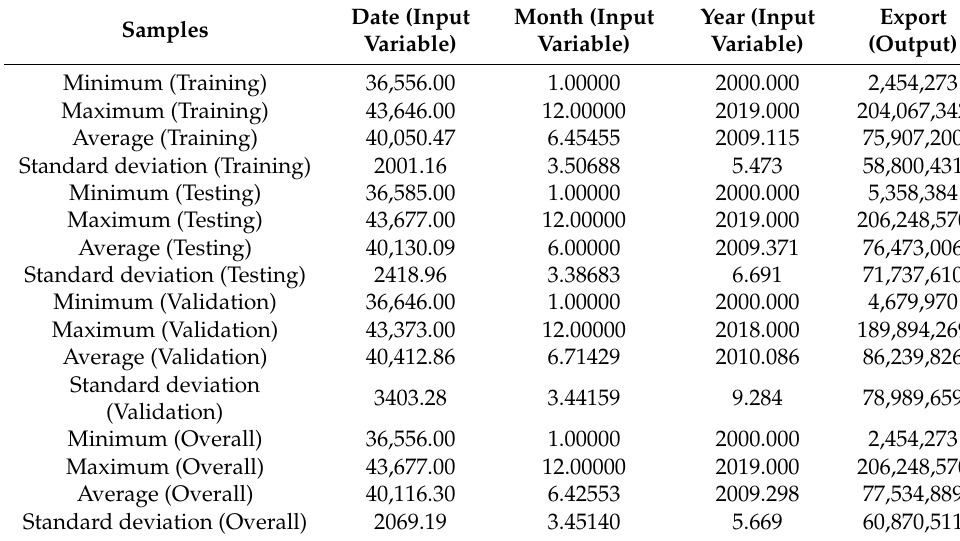
Table 1. Basic statistical characteristics of the monitored data set.